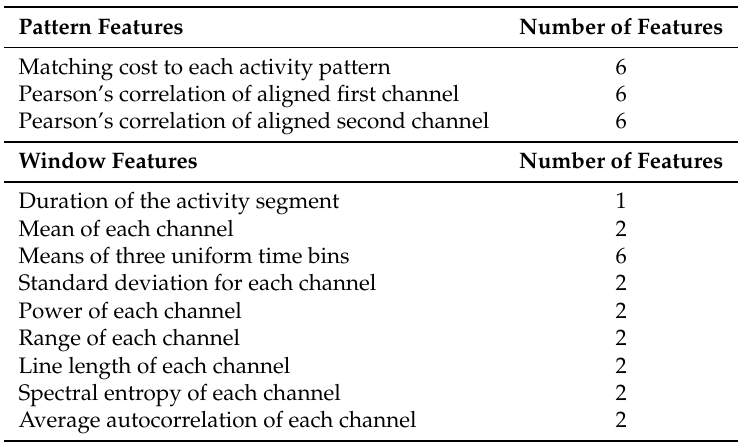
Table 2. Summary of all features used for activity